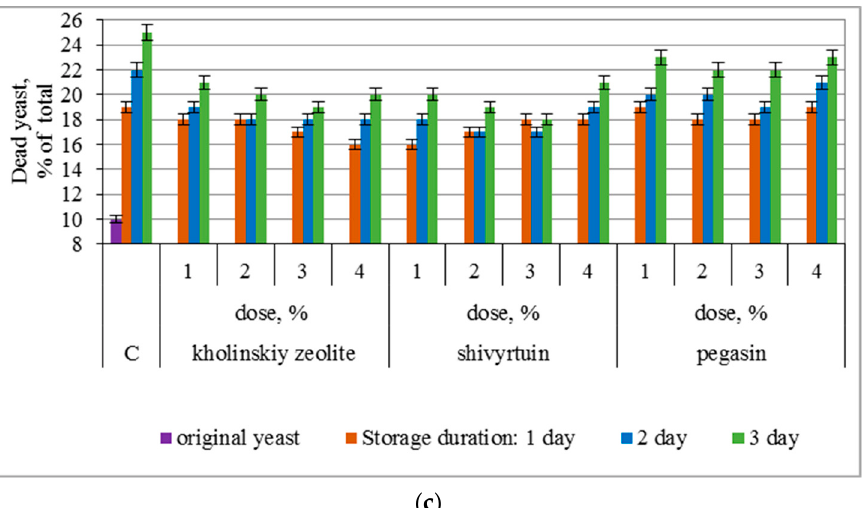
Figure 1. Changes in the physiological parameters of yeast culture stored under a layer of water with natural ZT (C—control sample, 1–4% values—dose of zeolite-containing tuffs): ( a ) the number of yeast cells with glycogen; ( b ) the number of budding yeast cells; ( c ) the number of dead yeast cells; ( p ≤ 0.05).